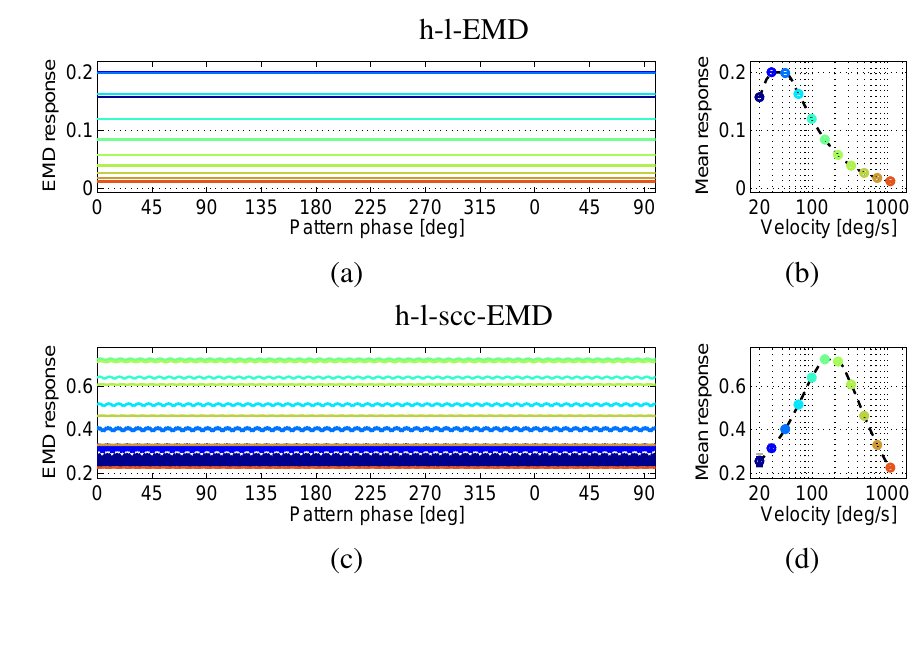
Figure 5. Responses of an h-l-EMD array (a, b) and an h-l-scc-EMD array (c, d) to a perfect sine pattern. (a) and (c) show the responses versus pattern phase for eleven different velocities after the initial response transient has faded away. (b) and (d) represent the velocity dependence of the mean response amplitude (logarithmic velocity axis). The dashed line represents the interpolated velocity curve. Markers indicate the mean values. Additionally the standard deviation is shown (too small to be visible here). (a, b) h-l-EMD array: The response shows the predicted nearly constant behaviour. (c,d) h-l-scc-EMD array: The response is oscillating. The amplitude of the oscillation is inversely correlated with the